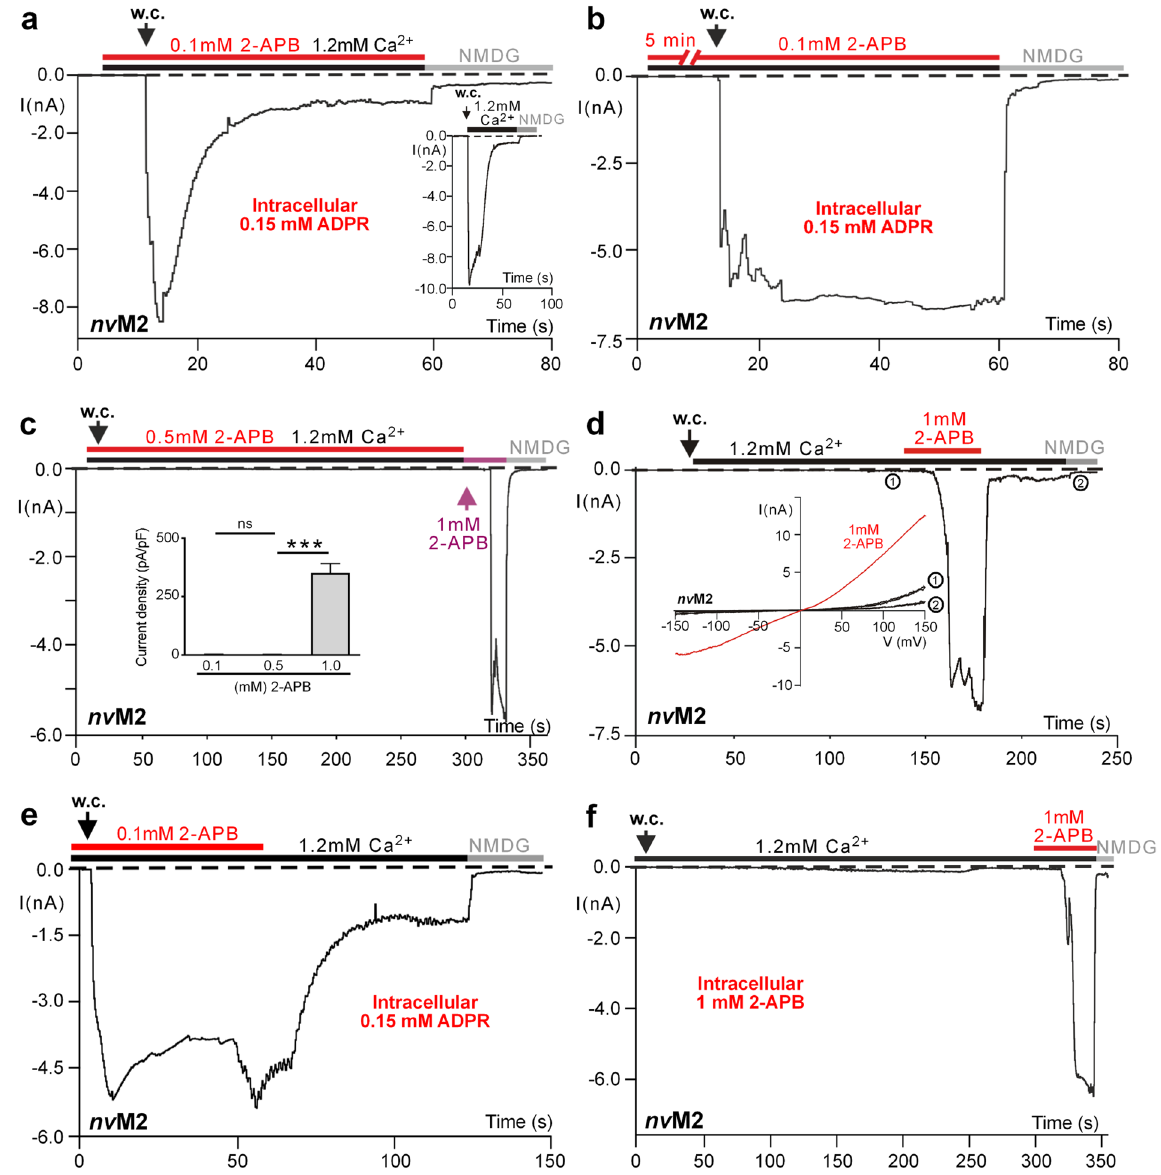
Figure 1. Effects on activation and inactivation of 2-APB on wild-type nv TRPM2 in patch-clamp experiments. ( a ) 2-APB does not inhibit ADPR-induced currents. 2-APB (0.1 mM) was added to the standard bath containing 1.2 mM Ca 2 + just before reaching whole-cell configuration (w.c.). ADPR (0.15 mM) was infused into the cell through the patch pipette together with 1 µ M Ca 2 + . As in the control experiment (inset), an immediate